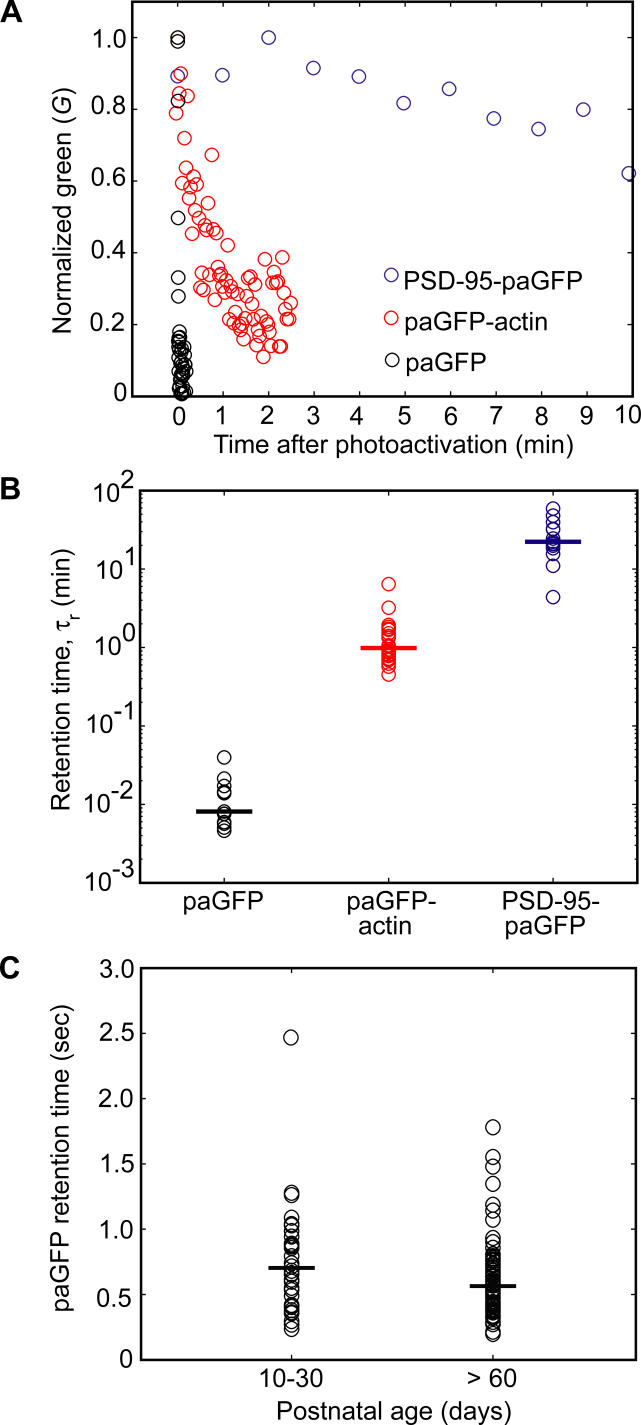
The Magnitude of the PSD-95 Retention Time Is Determined by Its Interactions with the PSD(A) Examples of the time course of paGFP* (black), paGFP*-actin (red), and PSD-95-paGFP* (blue) fluorescence after photoactivation in single spines (age, P10).(B) Retention times for paGFP*, paGFP*-actin, and PSD-95-paGFP* (age, P10) (circles indicate individual spines; bars indicate medians) (median τ
paGFP = 0.47 s, range, 0.28–1.28 s, n = 2 animals, 11 spines; median τ
paGFP-actin = 0.98 min, range, 0.45–6.42 min, n = 3 animals, 26 spines; median τ
PSD-95-paGFP = 22 min, range, 4–59 min, n = 2 animals, 15 spines).(C) Escape time for paGFP* from individual spines (circles) as a function of age. (P10–P30: τ
median = 0.72 s, range 0.28–2.38 s, n = 4 animals, 35 spines; > P60: τ
median = 0.58 s, range 0.24–1.78 s, n = 1 animal, 105 spines).